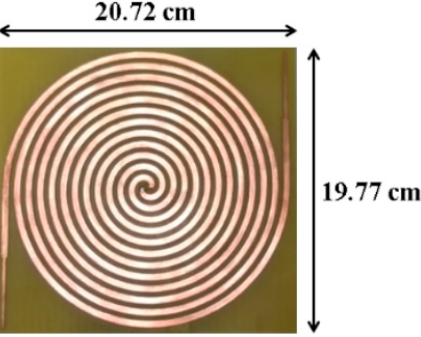
Figure 7. Prototype of the manufactured Archimedean spiral antenna.